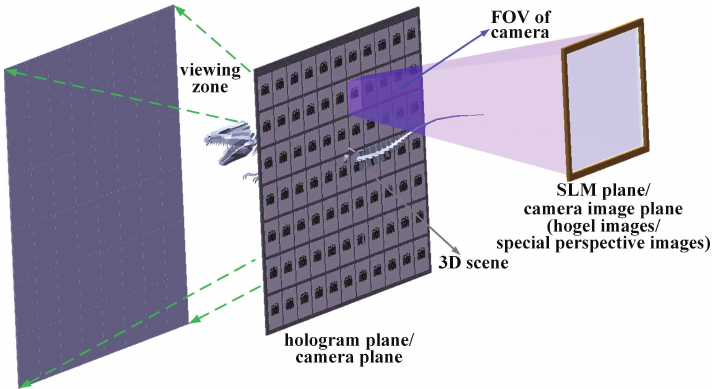
Figure 7. Hogel images are generated by a camera placed on the hologram